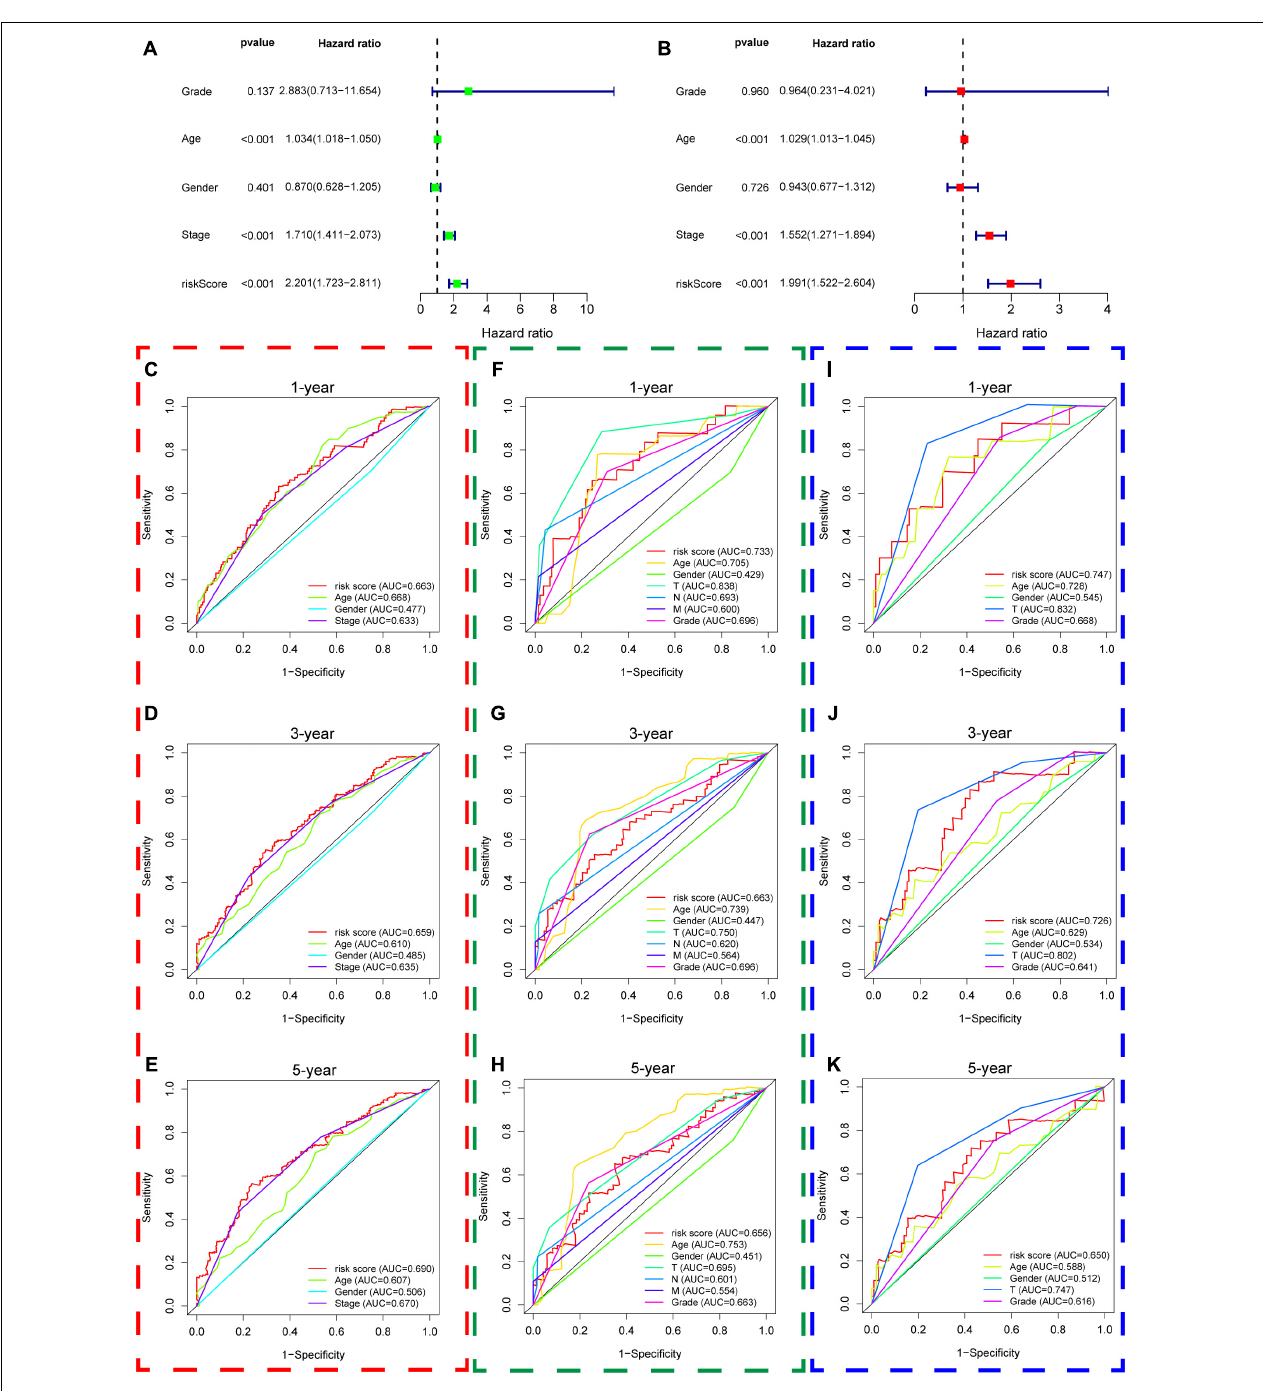
FIGURE 8 | The predictive performance of the risk score and other clinicopathological parameters. (A,B) The univariate and multivariate Cox regression suggested that the risk score was an independent prognostic factor in the training dataset. The red, green, and blue dashed boxes corresponded to the TCGA database, GSE13507, and GSE32548, respectively. (C–E) Showed the 1-year multiple ROC curves of the risk score and other clinicopathological parameters in the training set, GSE13507, and GSE32548, respectively. (F–H) Showed the 3-year multiple ROC curves of the risk score and other clinicopathological parameters in the training set, GSE13507, and GSE32548, respectively. (I–K) Showed the 5-year multiple ROC curves of the risk score and other clinicopathological parameters in the training set, GSE13507, and GSE32548,